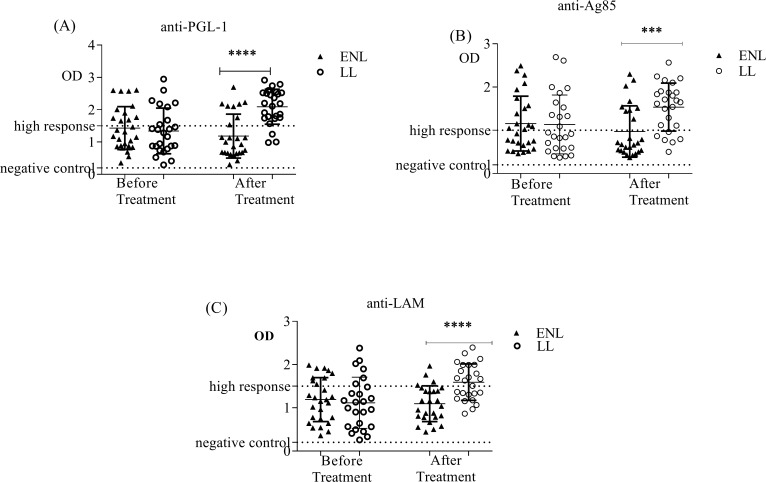
Serological responses to antigens in patients with ENL compared to LL patient controls before and after prednisolone treatment of patients with ENL reaction.(A): response to M. leprae PGL-1 antigen; (B): response to M. leprae Ag85 antigen; (C): response to M. leprae LAM antigen; Number of ENL = LL = 25; Statistical test: Mann-Whitney unpaired test (U). *** P≤0.001; **** P<0.0001. Error bars show median ± interquartile range.